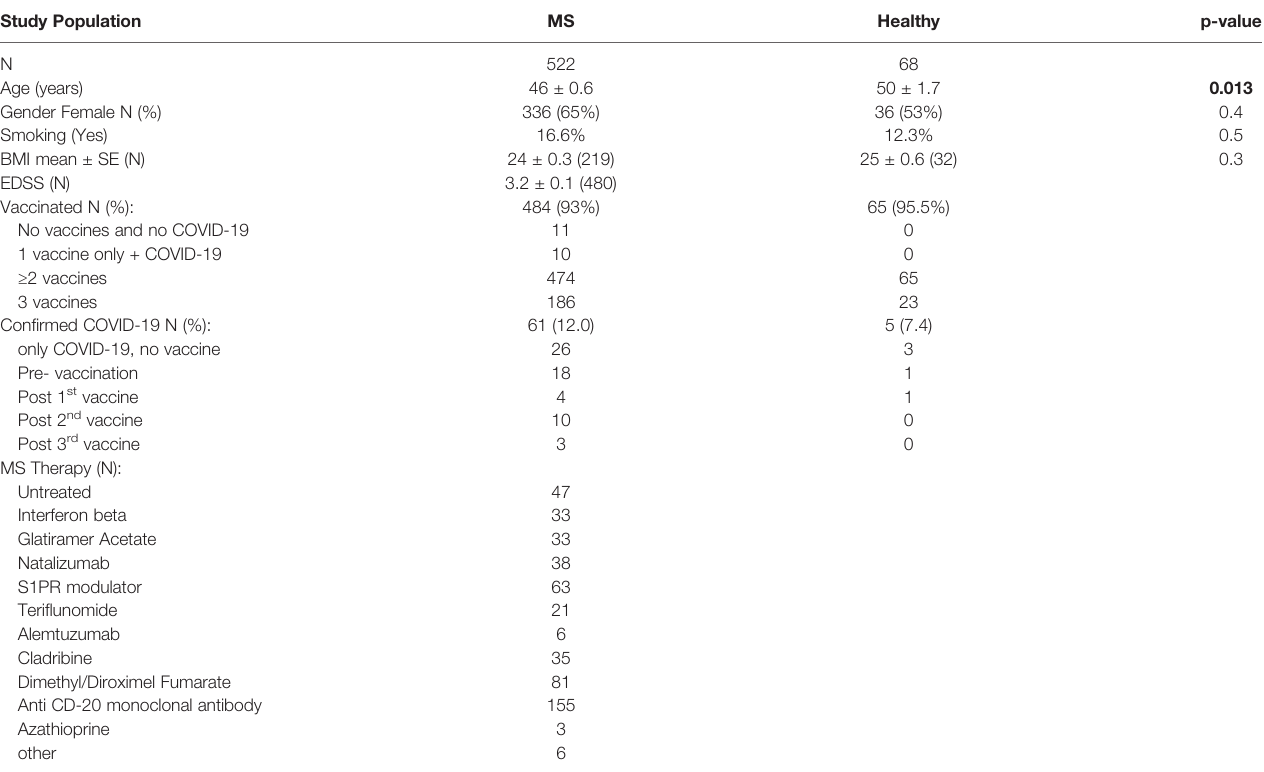
TABLE 1 | Demographic and clinical characteristics of study